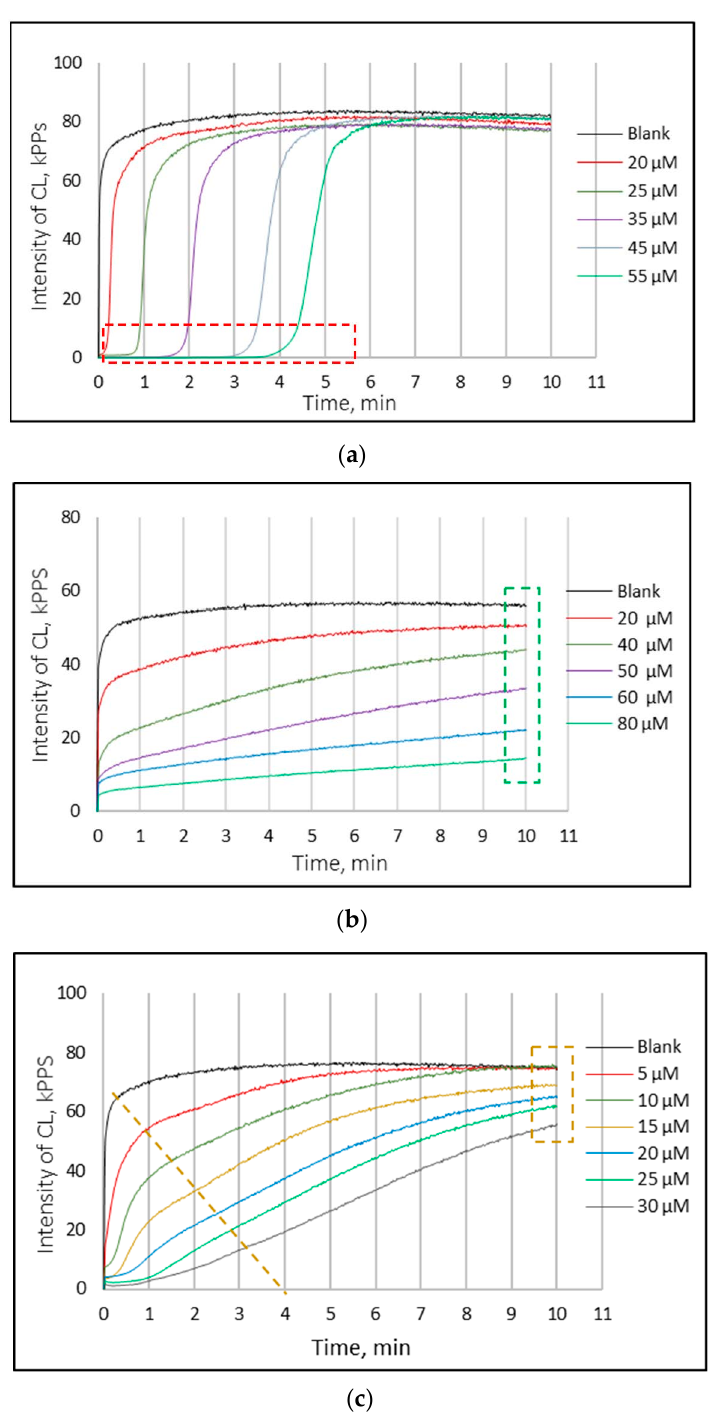
Figure 2. Effects of standard antioxidants on chemiluminescence kinetics: ( a ) sodium ascorbate; ( b ) tocopherol; ( c ) quercetin.